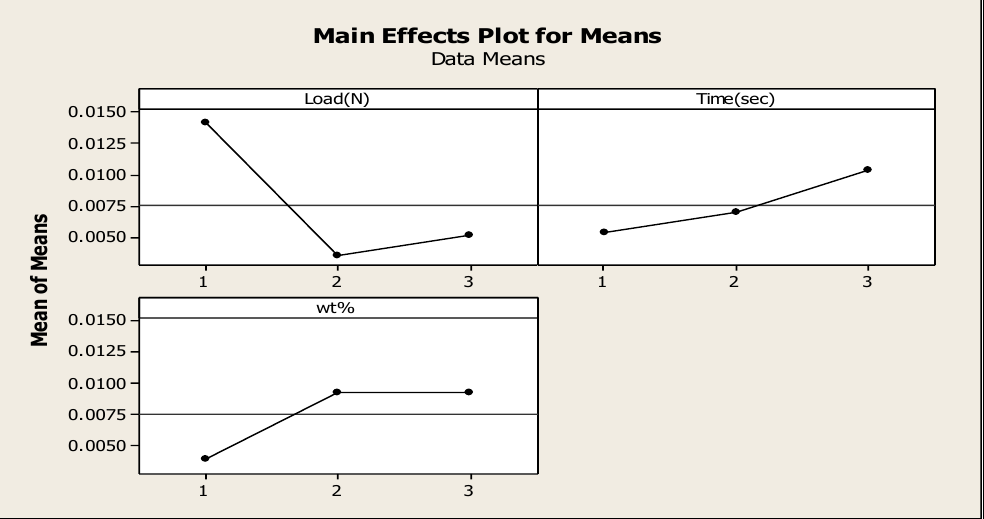
Figure 18: Main effect plots for means - Wear rate at high speed.